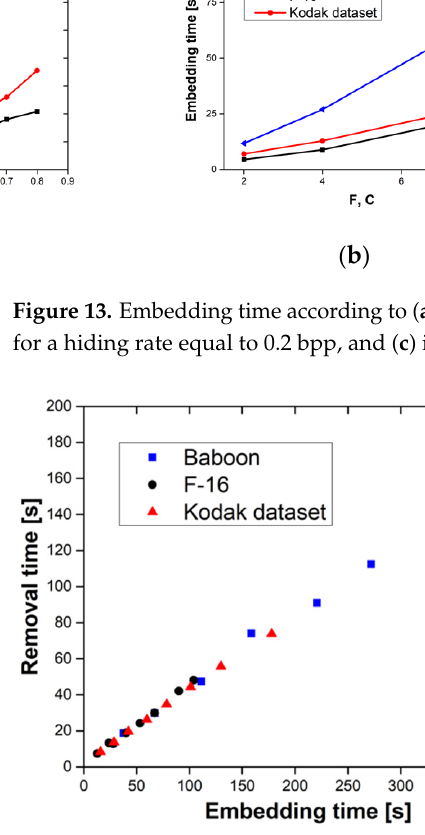
Figure 14. Relation between embedding time and removal time using Figure 13a information.